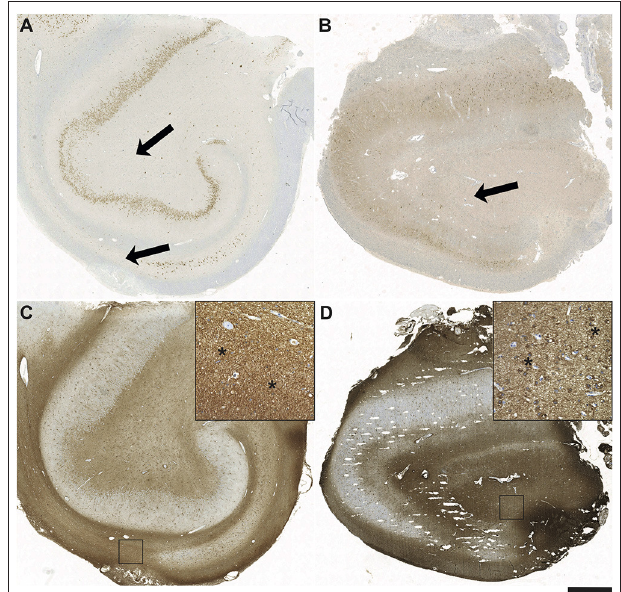
FIGURE 5 | Fibrillary and cellular astrogliosis in antibody positive HS Type 3 and seronegative HS Type 1. Sections after immunohistochemistry with antibodies against NeuN demonstrating a hippocampal formation of (A) a seronegative patient with pharmacorefractory TLE and HS Type 1 with subtotal segmental neuronal loss in CA1 (arrows) and also in CA3/CA4 in contrast to (B) the patient positive for GAD65 antibodies with “ end folium sclerosis” given by subtotal neuronal loss in the hilus (arrow; HS Type 3). Note also the severe neurodegeneration of dentate gyrus (DG) granule cells. Glial fibrillary acidic protein (GFAP) positive astrogliosis is most strongly present in hippocampal areas with the most massive neuronal loss in CA1 in Type 1 HS (C) vs. CA3/CA4 in Type 3 HS (D) . Note the different types of mainly fibrillary gliosis in Type 1 (insert in C – magnification from square; asterisks) vs. pronounced cellular astrogliosis in Type 3 HS (insert in D – magnification from square; asterisks); scale bar corresponds to 1,000 µ m in A-D and to 100 µ m in inserts.